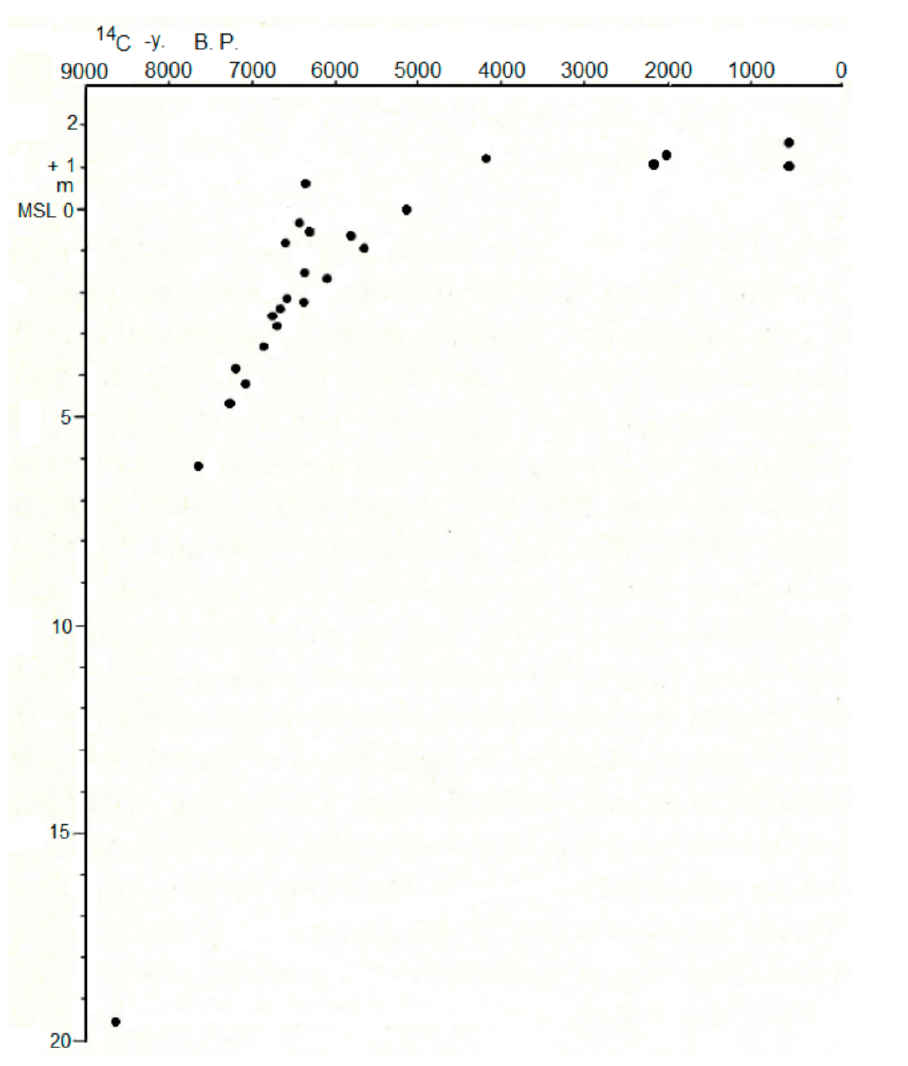
Figure 2. Sea level rise at the Suriname coast (modified after